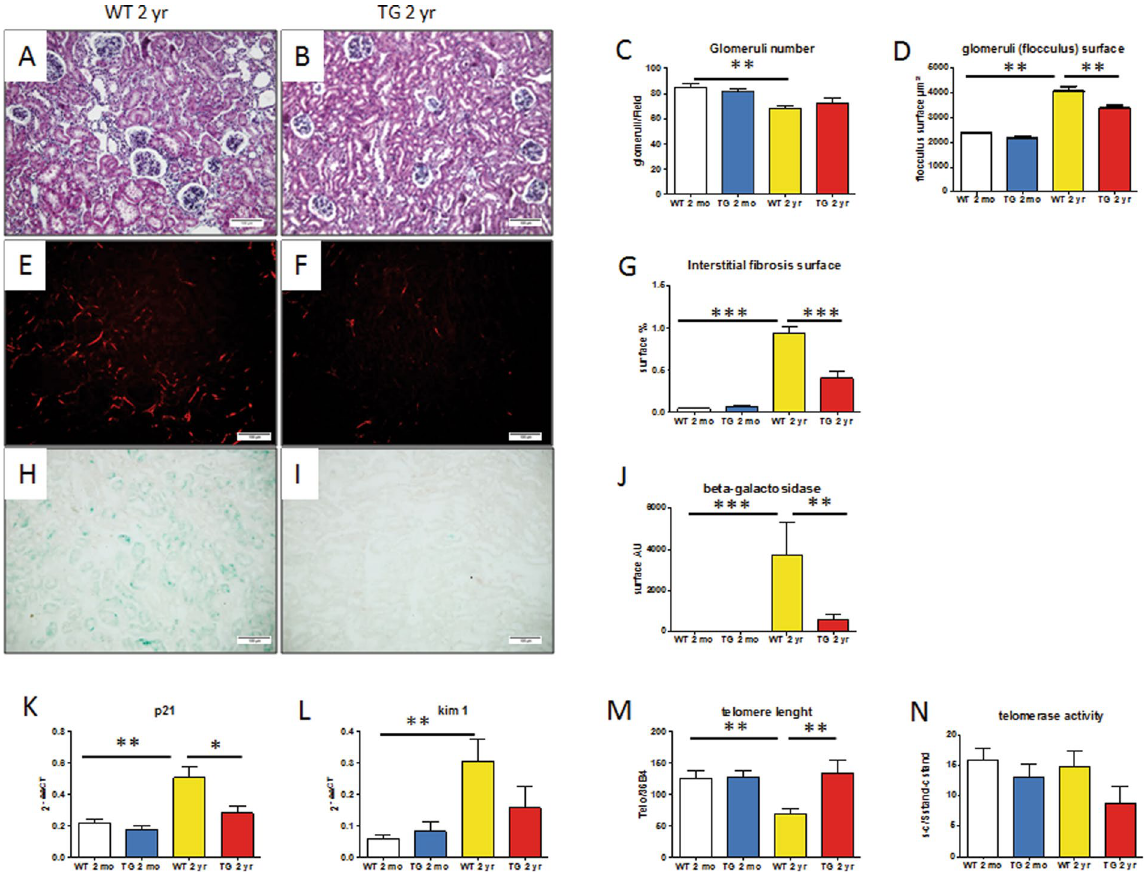
Figure 2. Calpastatin overexpression protects against kidney aging. At 2 years, CalpTG (TG) mice kidney was less impacted by aging than WT mice bred in the same conditions ( A,B ). The number of glomeruli/field decreased in WT animals at 2 years ( C , * p < 0.05, n = 10/group). By contrast, the number of glomeruli did not decrease significantly in CalpTG animals. At 2 years, kidneys were affected by glomerulosclerosis and enlarged glomeruli in WT animals, but these lesions were significantly less important in CalpTG mice ( D , ** p < 0.01, n = 10/group, magnification × 200). Fibrosis quantification was assessed by sirius red morphometry under polarized light, revealing that at 2 years, interstitial fibrosis surface was reduced in CalpTG mice when compared to aged WT ( E–G , *** p < 0.001, n = 10/group, magnification × 200). Beta-galactosidase activity, a marker of senescence was dramatically reduced at 2 years in CalpTG mice ( H–J , * p < 0.05, n = 5/group, magnification × 200). p21, another classical marker of senescence was also less expressed in CalpTG animals at 2 years ( K , * p < 0.05, n = 6/group). Kim-1, a marker of tubular injury increased significantly with aging only in WT mice ( L , ** p < 0.01, n = 6/group). Telomere shortening was significantly more important in WT mice at 2 years in comparison to CalpTG animals ( M , ** p < 0.01, n = 10/group). The protection of telomeres in CalpTG mice could not be ascribed to increased telomerase activity (N, n =